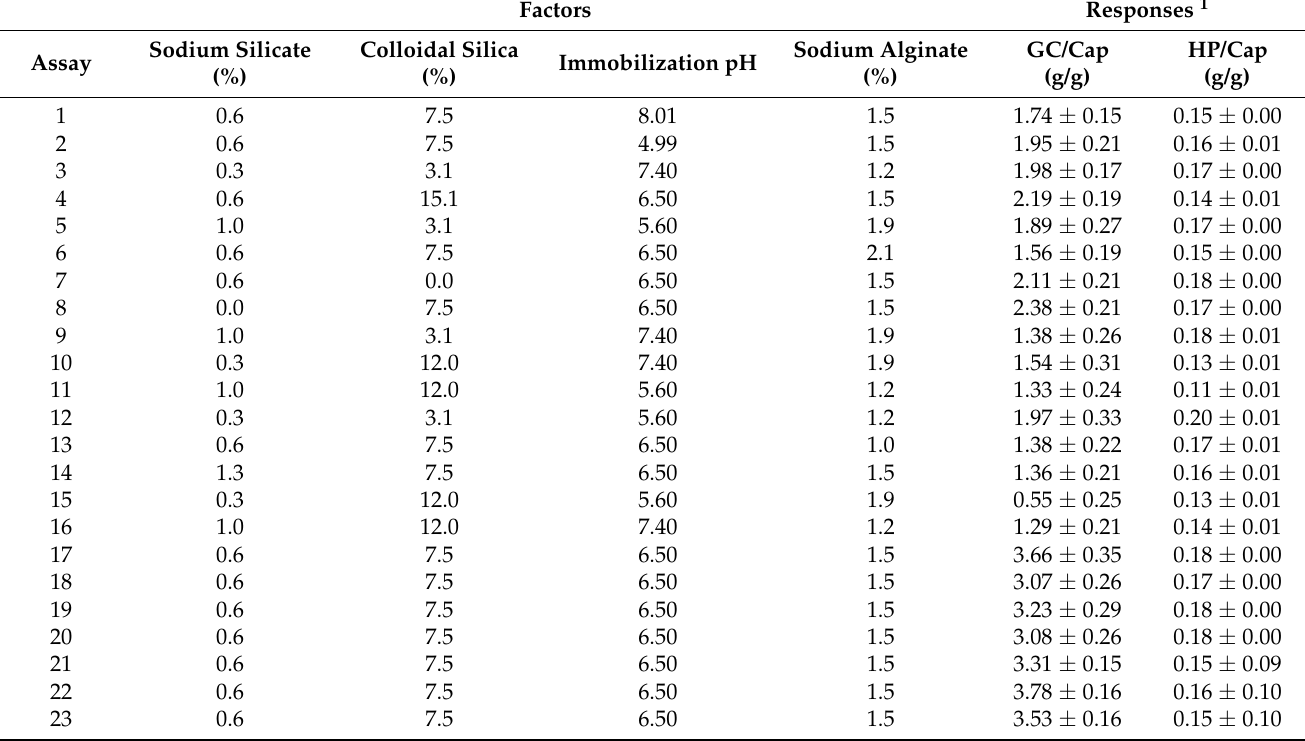
Table 1. Reduced Draper-y-Lin composite design with the 23 types of enzyme-containing capsules and the two response variables. Factors Responses 1